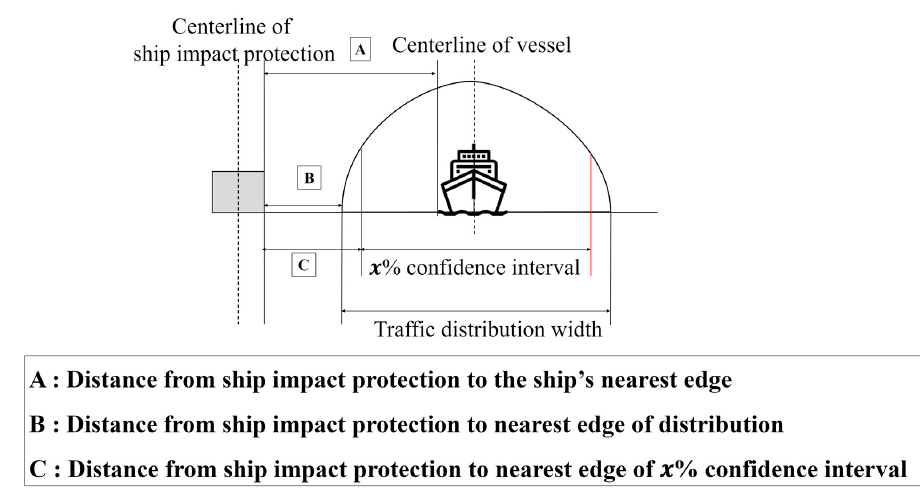
Figure 11. Method used for analyzing the ship safety distance.